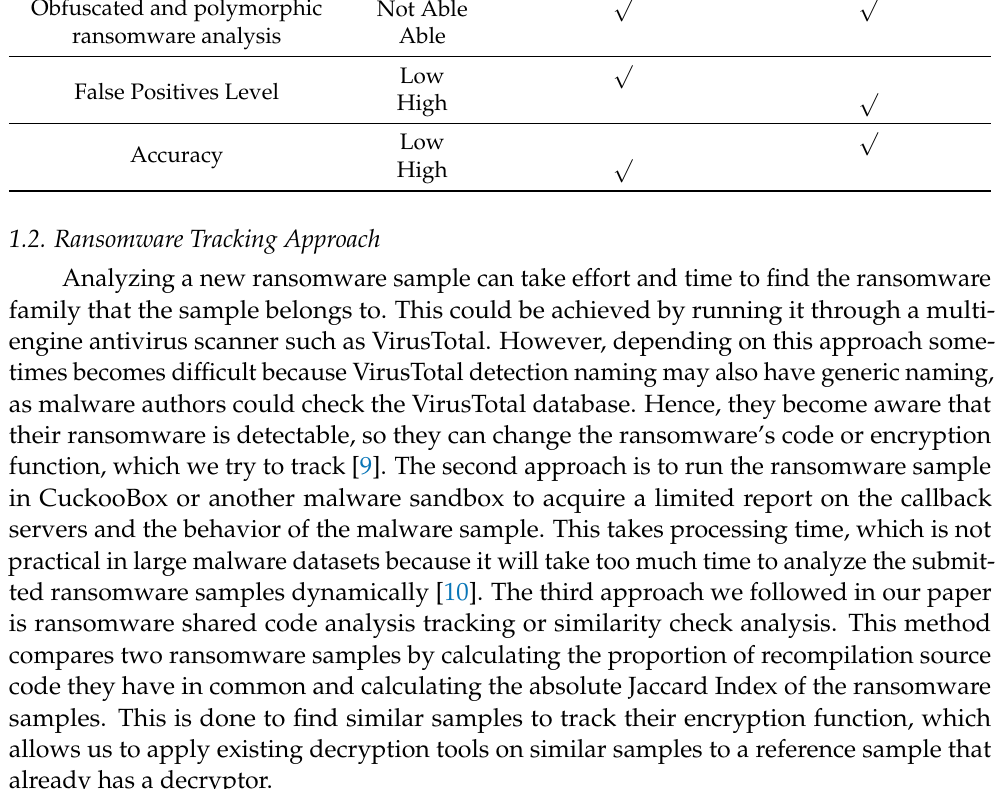
Low Low High Not